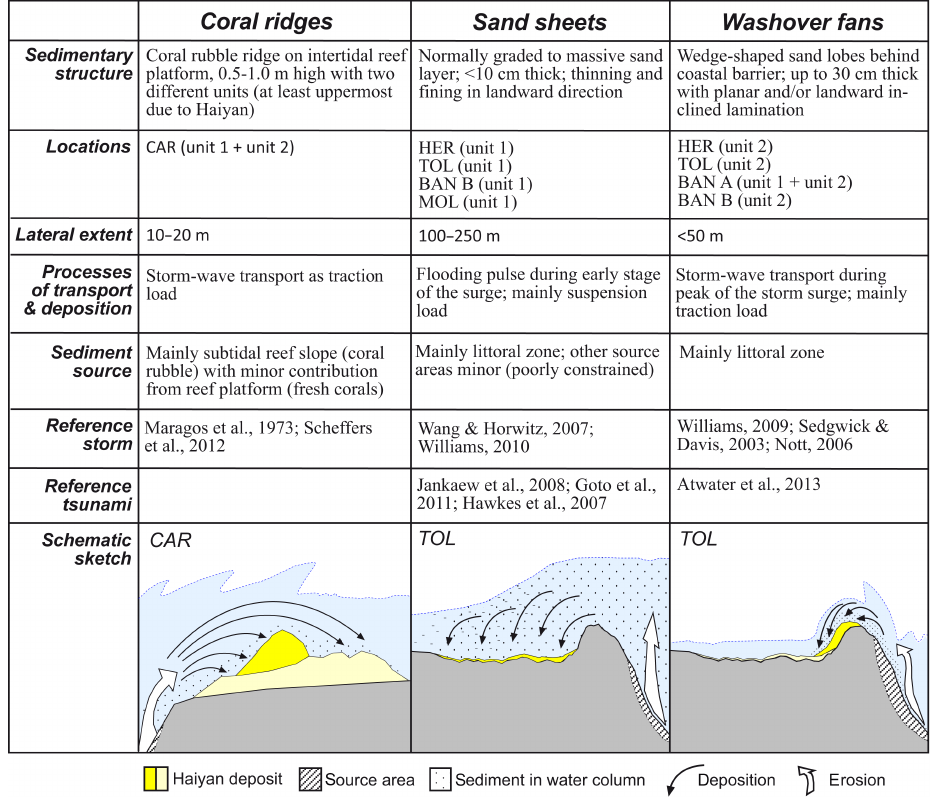
Figure 14. Compilation of sedimentary characteristics and inferred formation processes for the three different types of Haiyan deposits: coral ridges, sand sheets, and washover fans. The cited references report on storm or tsunami signatures with similar